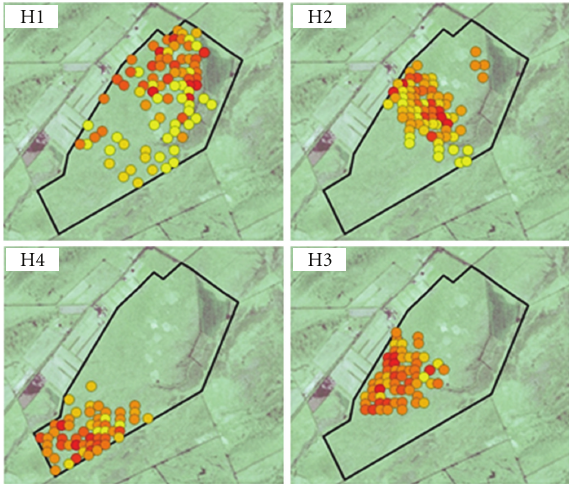
Figure 3: Location of the four harems in the pasture. The horses are most often found where the reddest spots are shown.